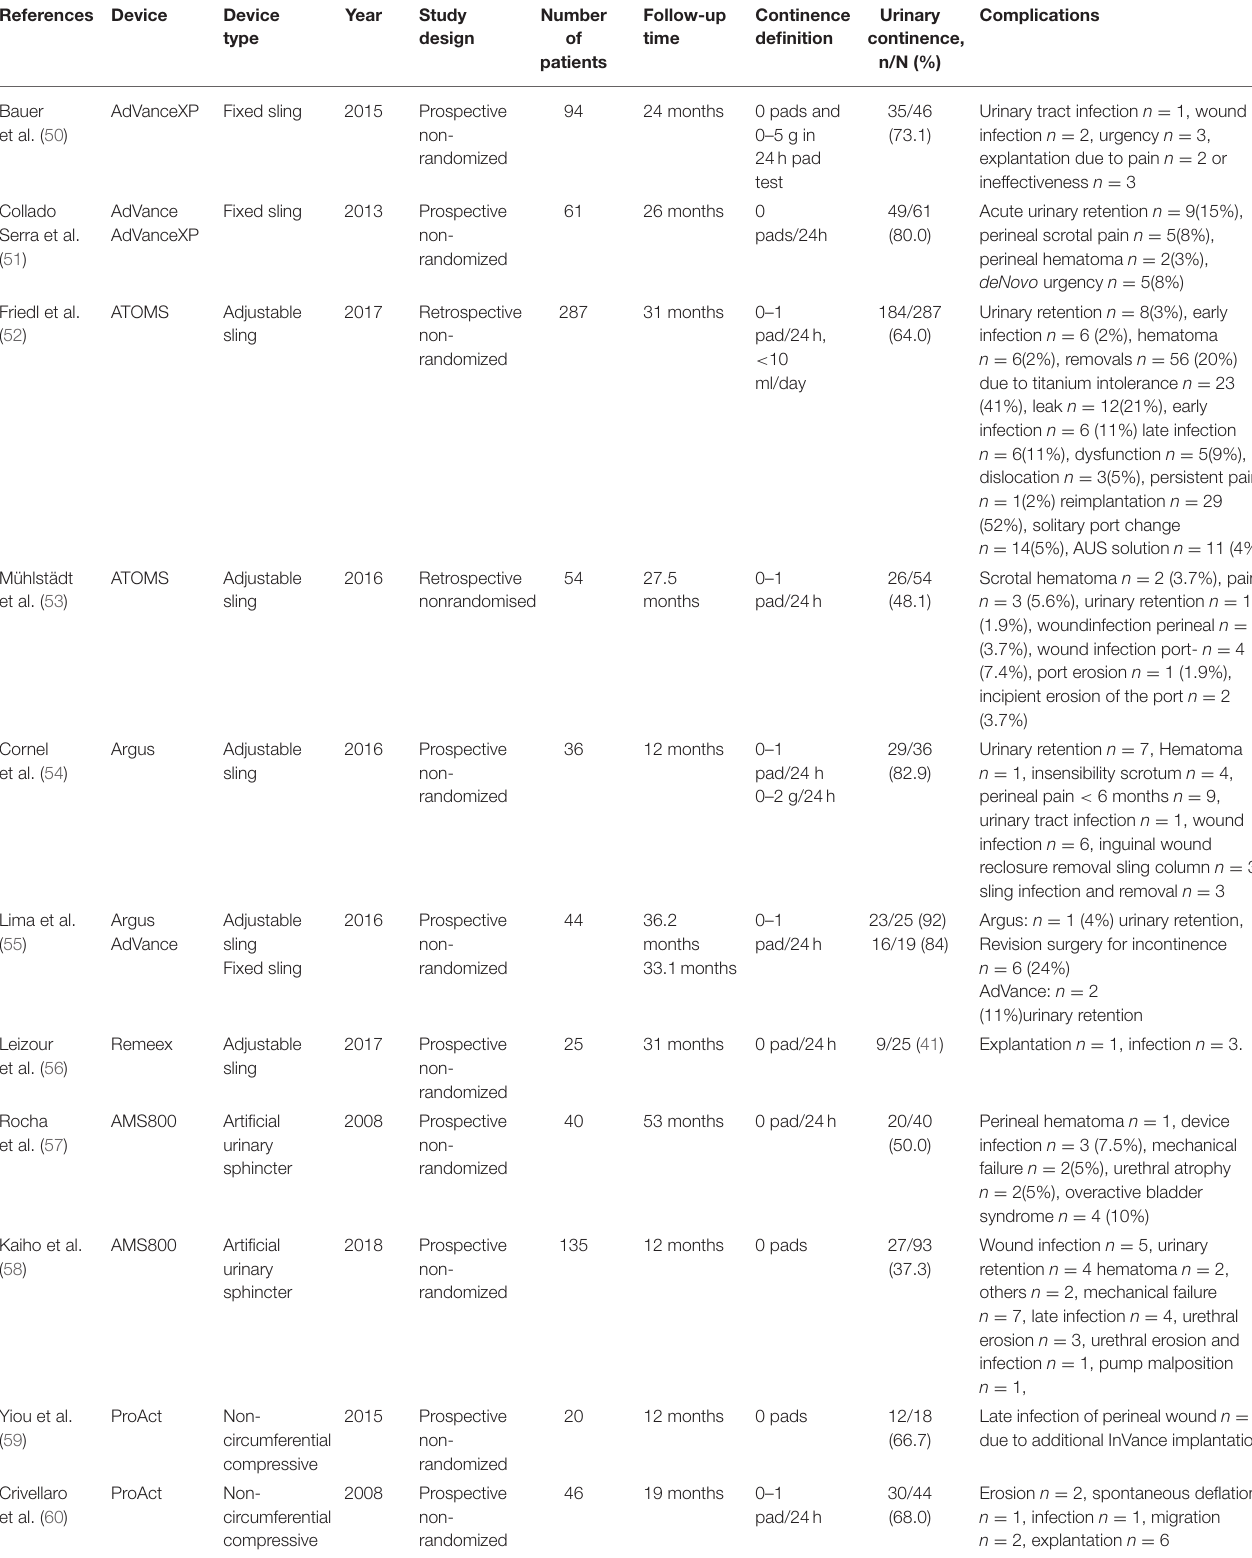
TABLE 2 | Continence and complications rates after different treatment modalities of male stress urinary incontinence in selected clinical